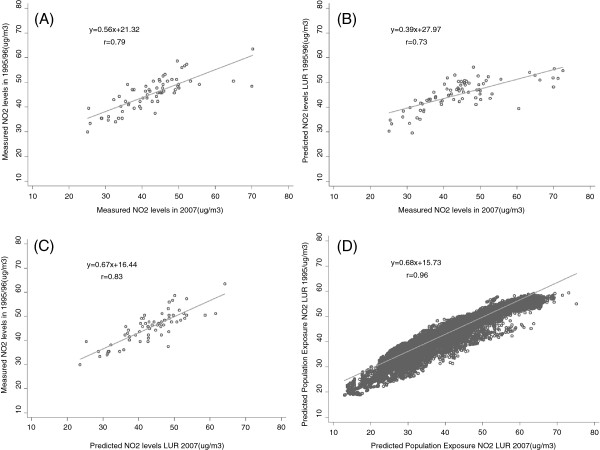
Comparison of the measurements of NO2concentrations taken at the same locations in the two study periods. (A), the ability of 1995/96 model to predict 2007 measurements (B), the ability of 2007 LUR model to predict 1995/96 measurements (C), and the comparison of predicted values of the two LUR models at the addresses of the study population (D).